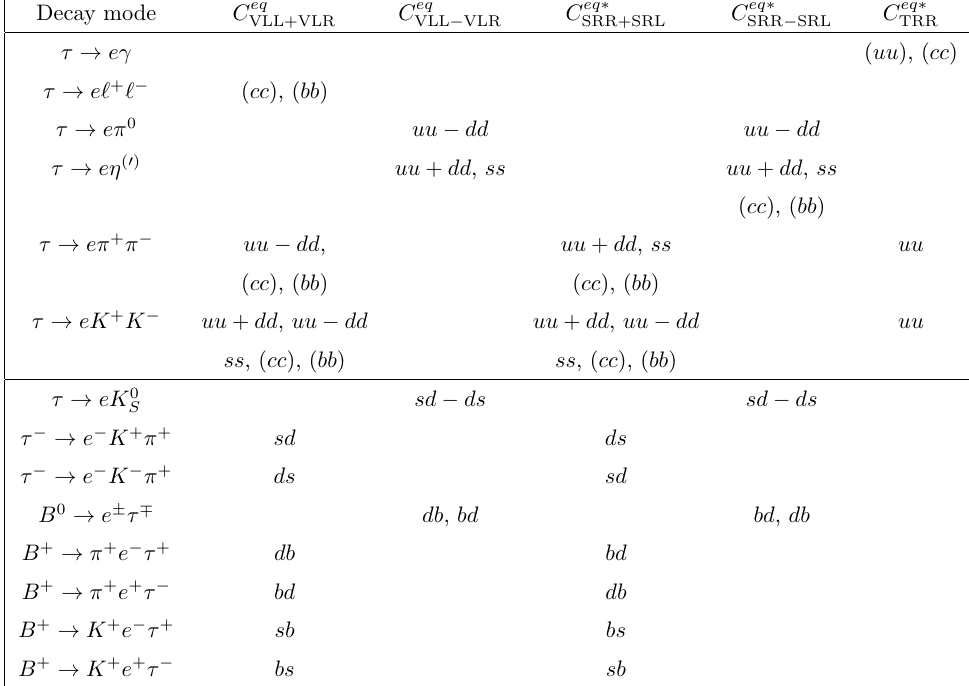
Table 16 . Dependence of low-energy decay channels on the coefficients of semileptonic LEFT operators at the matching scale µ ∼ v . We focus here on operators with left-handed electrons, an analogous table can be made for operators with right-handed electrons. The parentheses imply that the operator induces the decay mode at the loop level, either in perturbation theory, e.g. via the (cid:1) RGE running of (cid:0) C ed onto four-lepton operators or the matching of (cid:0) C ed ∗ VLL+VLR τebb onto C at the m threshold, or via hadronic loops, e.g. the contribution of ( C eu ∗ b G e G We ignore d -type tensor operators, which are not induced by matching onto SMEFT.